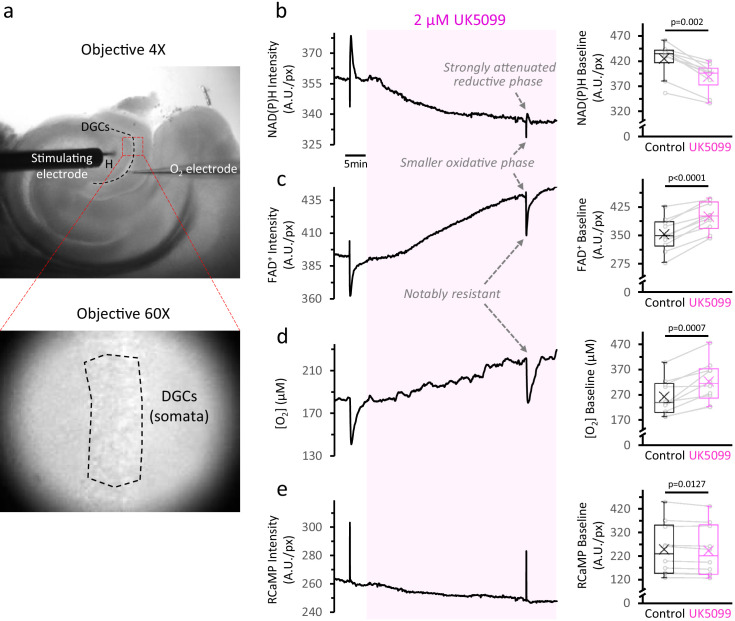
Inhibition of the mitochondrial pyruvate carrier slows down the TCA cycle and decreases O2 consumption at baseline.(a) Top: Low-magnification image of an acute brain slice of the hippocampus, showing the placement of the stimulating electrode in the hilus (H) and the O2 electrode in the layer of dentate granule cells (DGCs). The red square represents the area used for imaging the NAD(P)H autofluorescence signals. Bottom: The identification of the area of interest (dashed-line polygon drawn in the DGC layer), was performed in infrared-illuminated/differential interference contrast images, obtained at high magnification (×60 objective) and a pixel binning of 8. (b) Left: Representative traces of NAD(P)H and FAD+ autofluorescence signals, extracellular oxygen concentration and RCaMP fluorescence, simultaneously recorded from a population of DGCs in a hippocampal slice. The shaded area corresponds to the application of 2 µM of the MPC inhibitor UK5099. Right: Effect of UK5099 treatment on the baseline level of each signal. Data points obtained before and after the application of UK5099 are connected by lines (Nslices = 10 and Nmice = 6 for NAD(P)H and FAD+ autofluorescence signals, along with RCaMP fluorescence). As shown in the representative trace, there were some experiments with oxygen and autofluorescence signals recorded simultaneously, but the full dataset for O2 measurements contained stand-alone O2 recordings as well (Nslices = 10 and Nmice = 5).